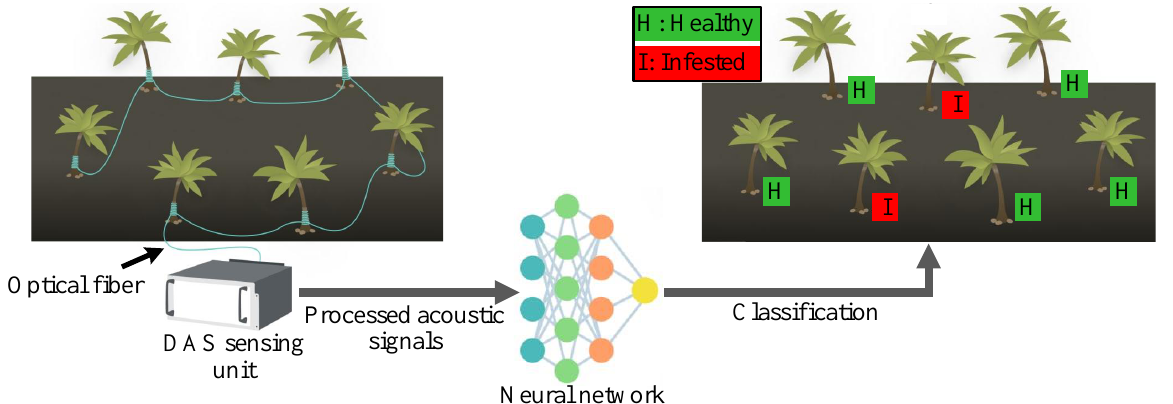
Figure 1. Overall approach for RPW detection using an optical fiber DAS and machine learning.